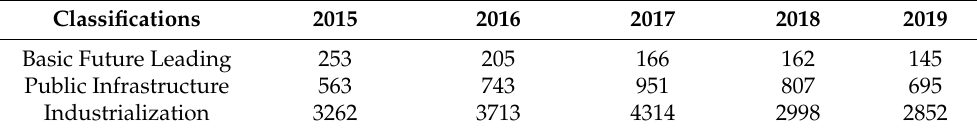
Table 4. Number of cases of technology transfer for each GRI mission type (2015–2019).